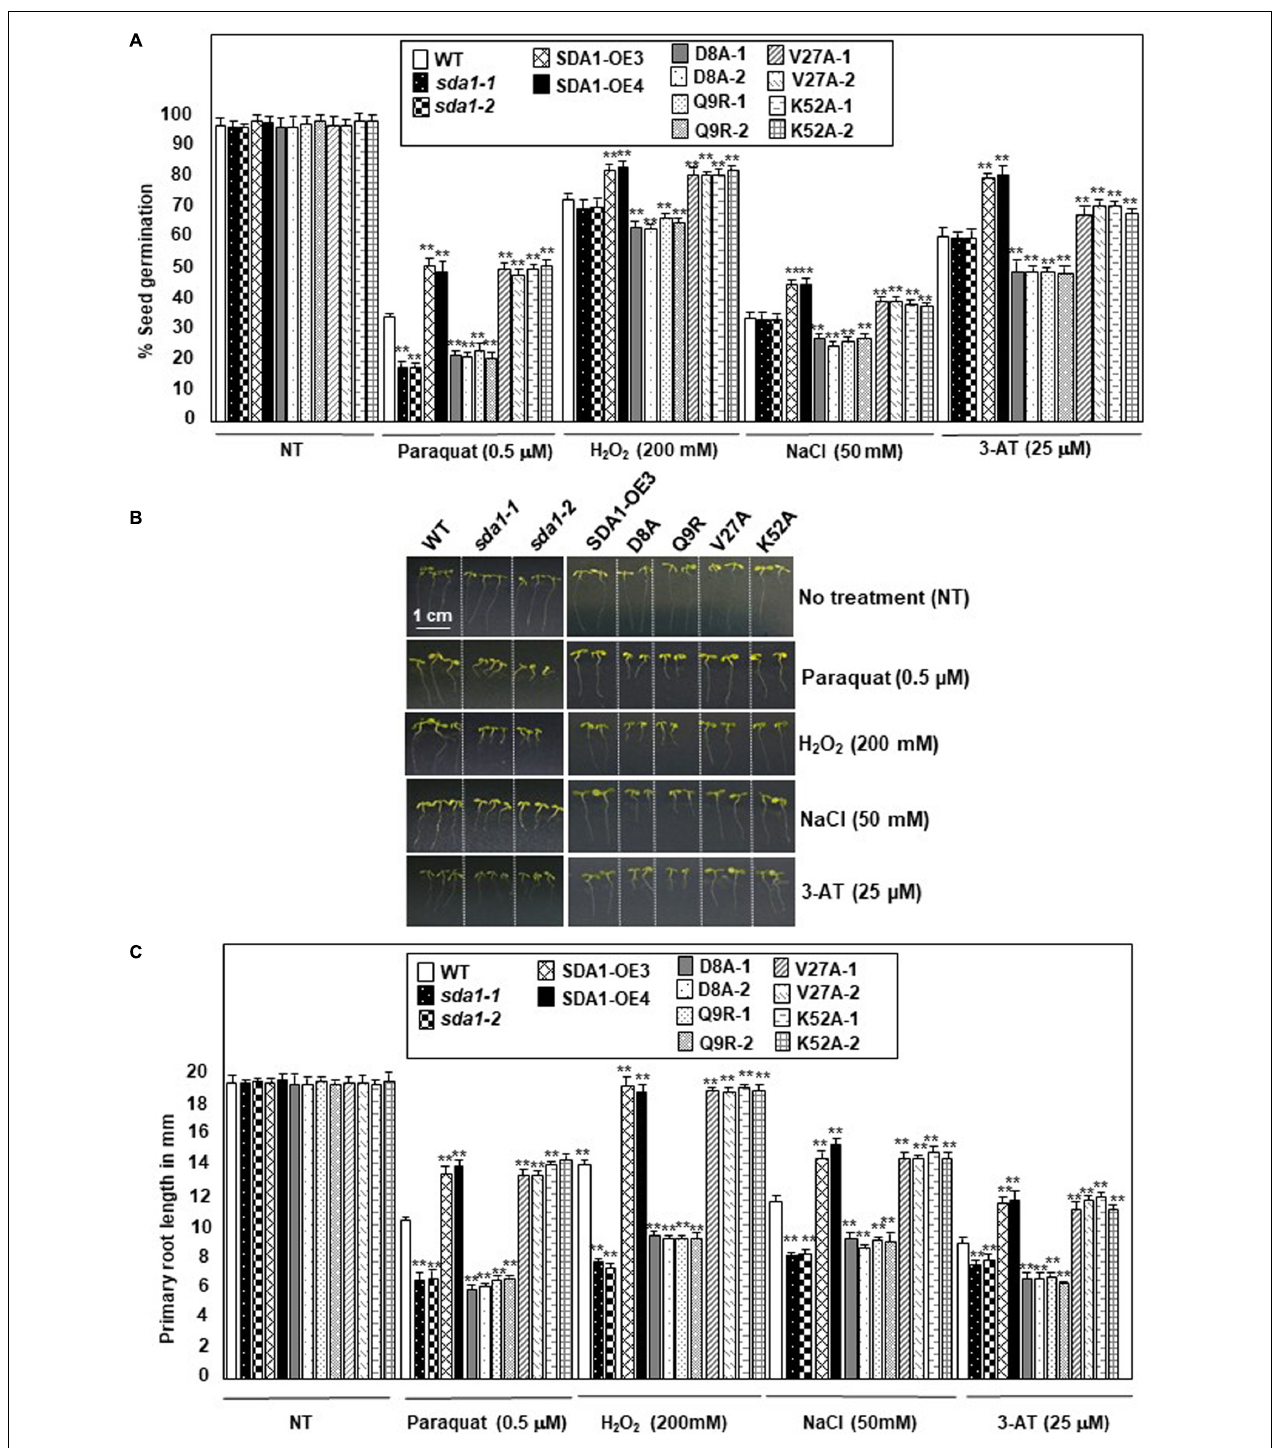
FIGURE 8 | SDA1 is required for tolerance to oxidative stress. (A) Percent seed germination of WT , sda1 mutants, pER8:: SDA1 plants, and various amino acids mutants of SDA1 expressed from pER8 promoter in the presence of oxidative stress inducing chemicals. (B) Representative 5-days-old seedlings of genotypes in (A) grown in the presence of indicated oxidative stress inducing chemicals. Scale bar is 1 cm for all samples. (C) Mean root length of seedlings in (B) . ( n = 25–35; Student’s t -test; ** p < 0.01). Statistical analysis was performed by one-way ANOVA followed by Dunnett’s test with reference to respective WT control of each treatment. Asterisks indicate statistically significant differences (** p < 0.01). All experiments were repeated twice and similar results were obtained. SDA1-OE3 and SDA1-OE4, SDA1 expressed from β -estradiol-inducible XVE system (pER8:: SDA1 , line # 3 and # 4); D8A, Q9R, V27A, K52A are various point mutants of SDA1 expressed from pER8